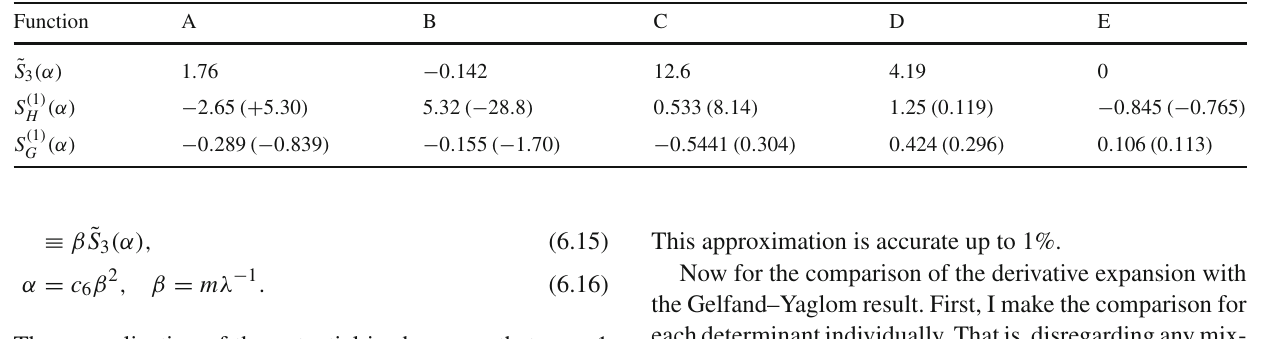
Table 2 Result for the dimensionless leading-order action and func- tional determinants. The ˜ S 3 (α) parametrization holds for 1 ≥ α ≥ 0. ( 1 ) (α) and S ( 1 ) (α) parametrizations are divided into two α While the S H G